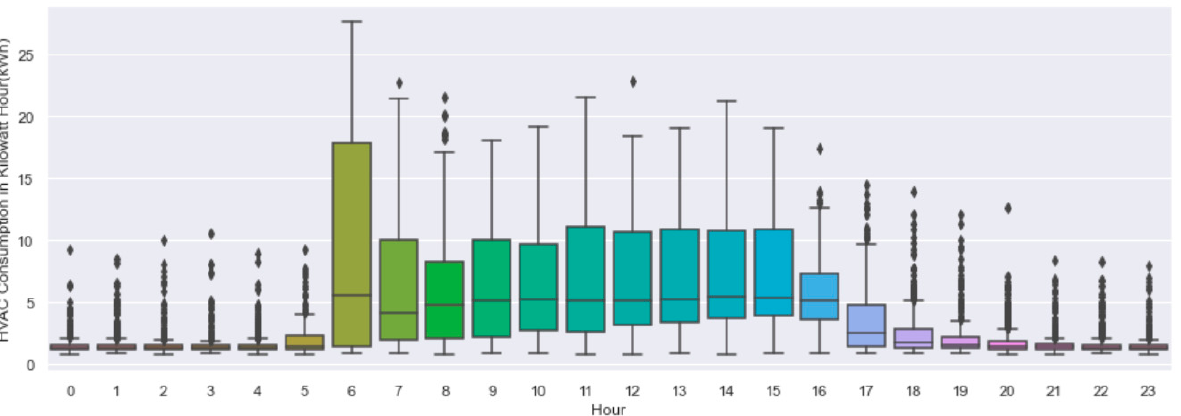
Figure 7 . HVAC consumption change per hour . Figure 7. HVAC consumption change per hour.